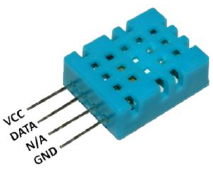
Figure 3. Temperature and humidity sensor module DHT11.